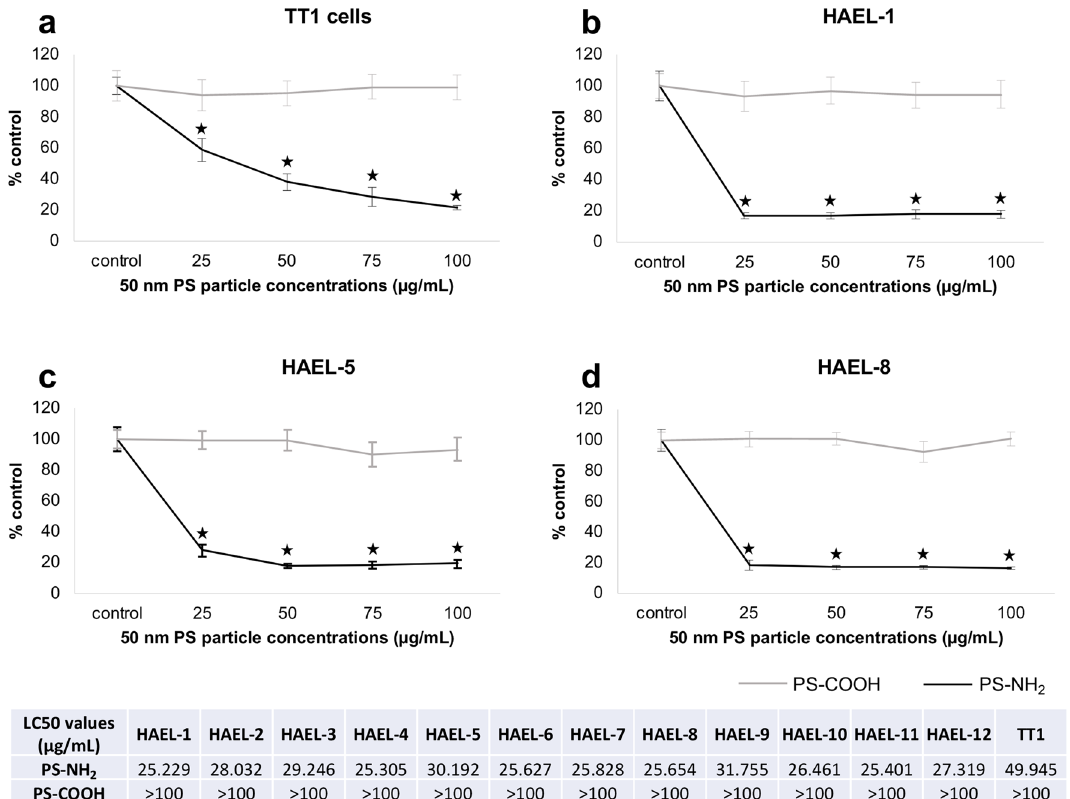
Figure 8. Cell viability (MTT assay) of TT1 cells ( a ) and ICs ( b – d ) exposed to 50 nm PS-NH 2 and PS-COOH particles for 24 h. Data are given as percentage with respect to controls (means ± SD). Stars indicate significant differences (p < 0.05) in treated cells with respect to controls according to the Kruskal–Wallis followed by the Dunn’s post hoc test. n = 6 replicates per treatment. LC50 values were calculated through Probit